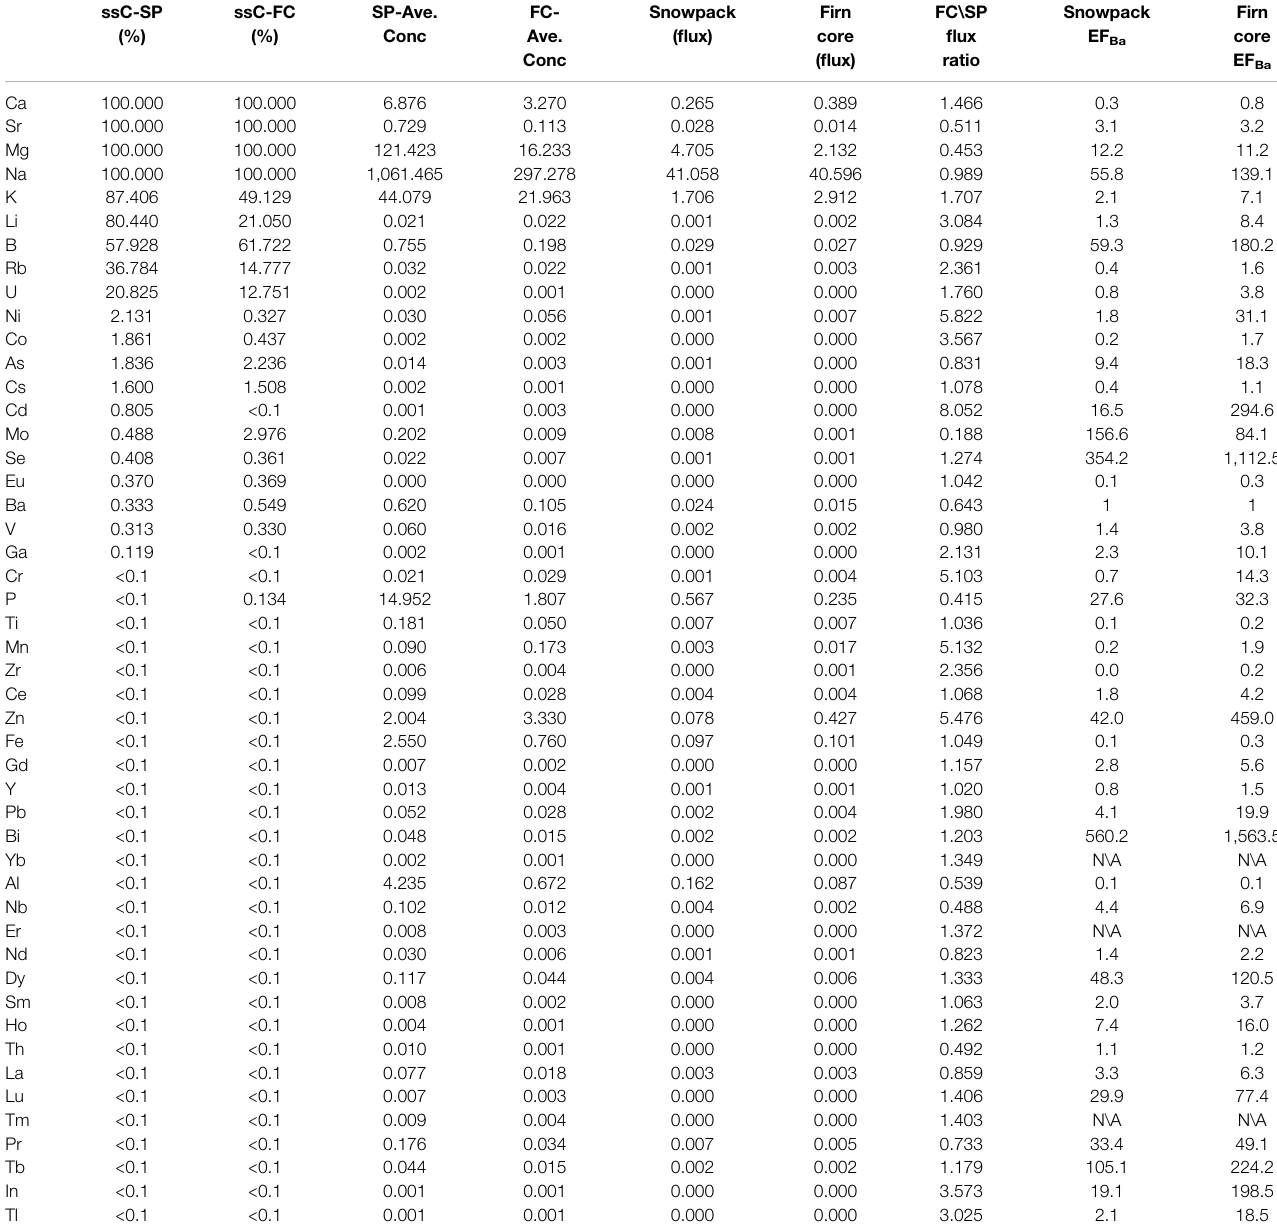
TABLE 1 | Average elemental concentration order based on its sea spray contribution in the snowpack (SP Ave. Conc) and the fi rn core (FC. Ave Conc) expressed both as ng g − 1 . ssC-SP (%)